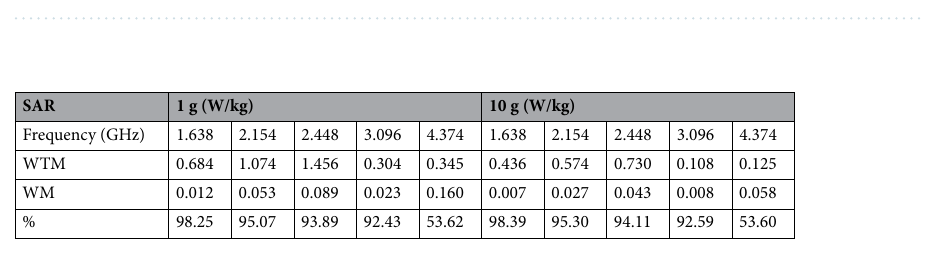
Table 10. 10 g SAR results with percentage values for various mobile distances from human head.